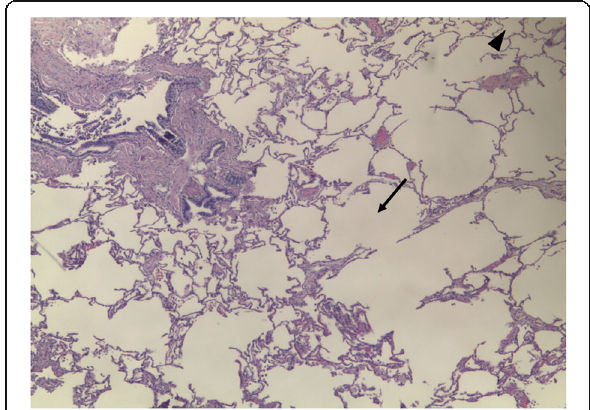
Fig. 3 Centrilobular emphysema. Low-power hematoxylin and eosin (H&E) stain shows emphysematous spaces surrounding the terminal bronchioles (arrow; arrowhead in normal parenchyma). Abnormally large airspaces are the result of the destruction of alveolar walls